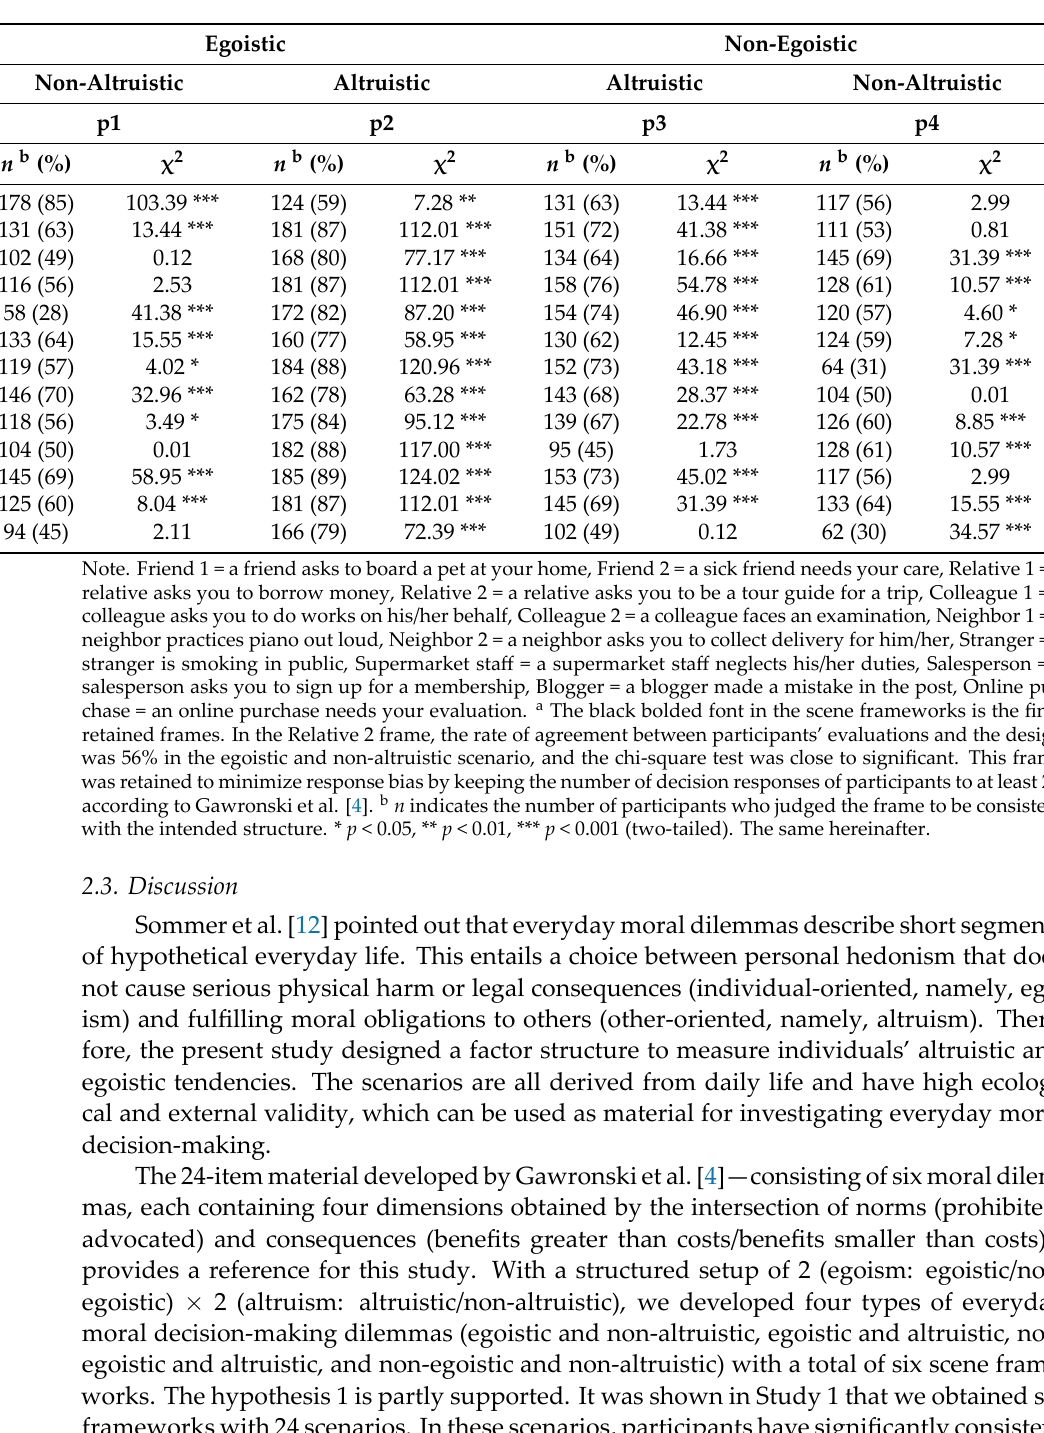
Table 2. Results of chi‑square test of participants’ judgments on 13 frameworks, including 52 Scenar‑ ios ( n =